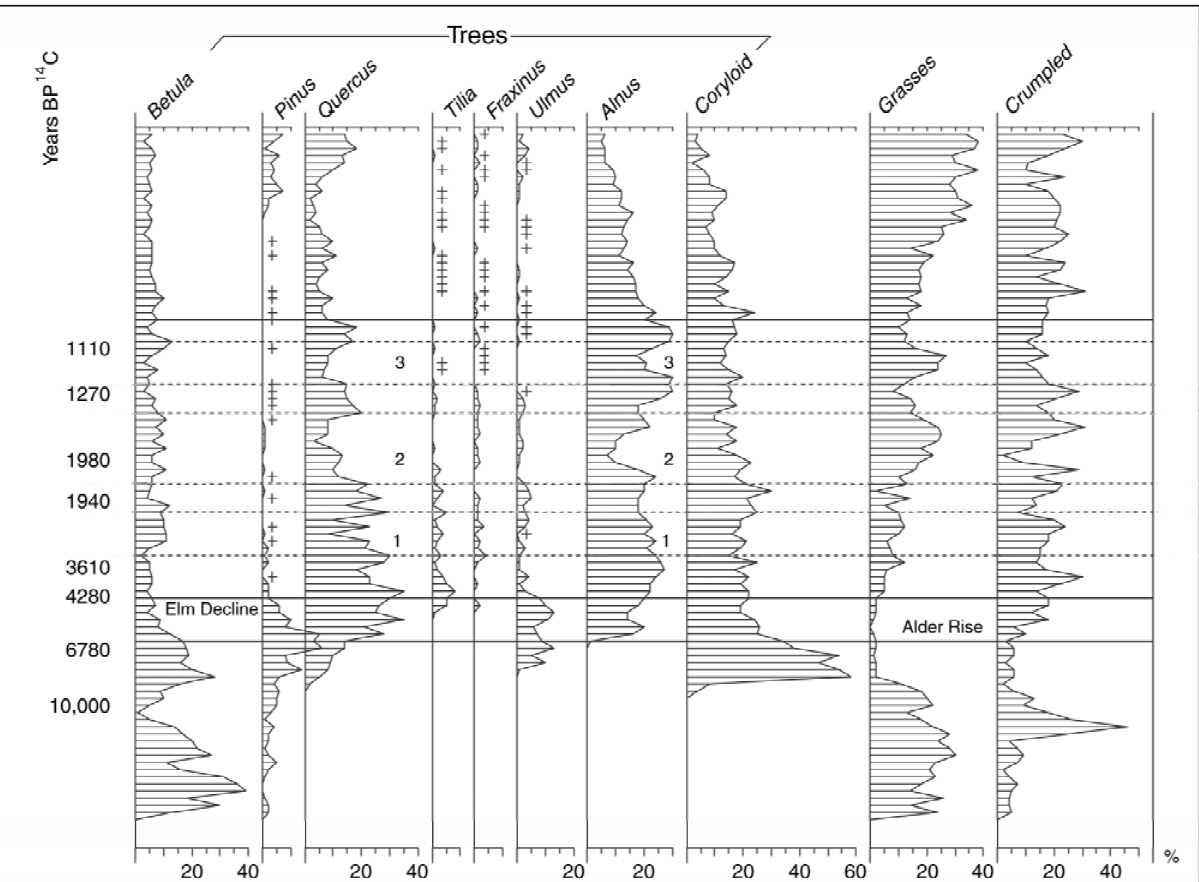
Fig 2.8 Pollen diagram from Coniston Water, Cumbria, where 1, 2 and 3 denote successive clearances of quercus and alnus each followed by regeneration and a transient peak of betula. The first episode of clearance is associated with an elm decline, with a gen- eral decline in Oak and Alder (I on diagram) from the Bronze Age onwards (after Pennington 1997, with permission from Geof- frey